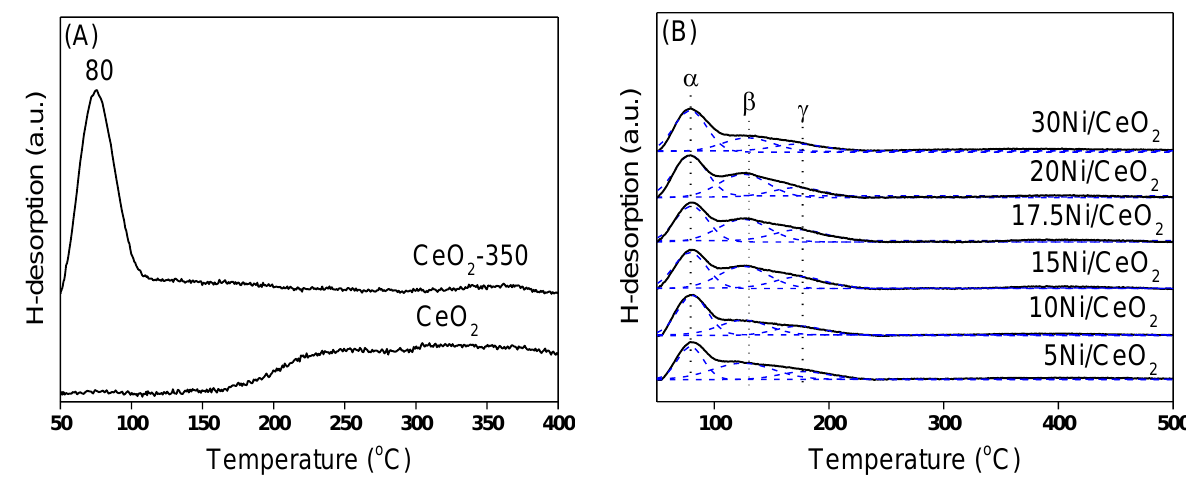
Figure 8. H 2 -TPD profiles of ( A ) the unreduced CeO 2 and reduced CeO 2 support (CeO 2 -350) and ( B ) xNi/CeO 2 catalysts.